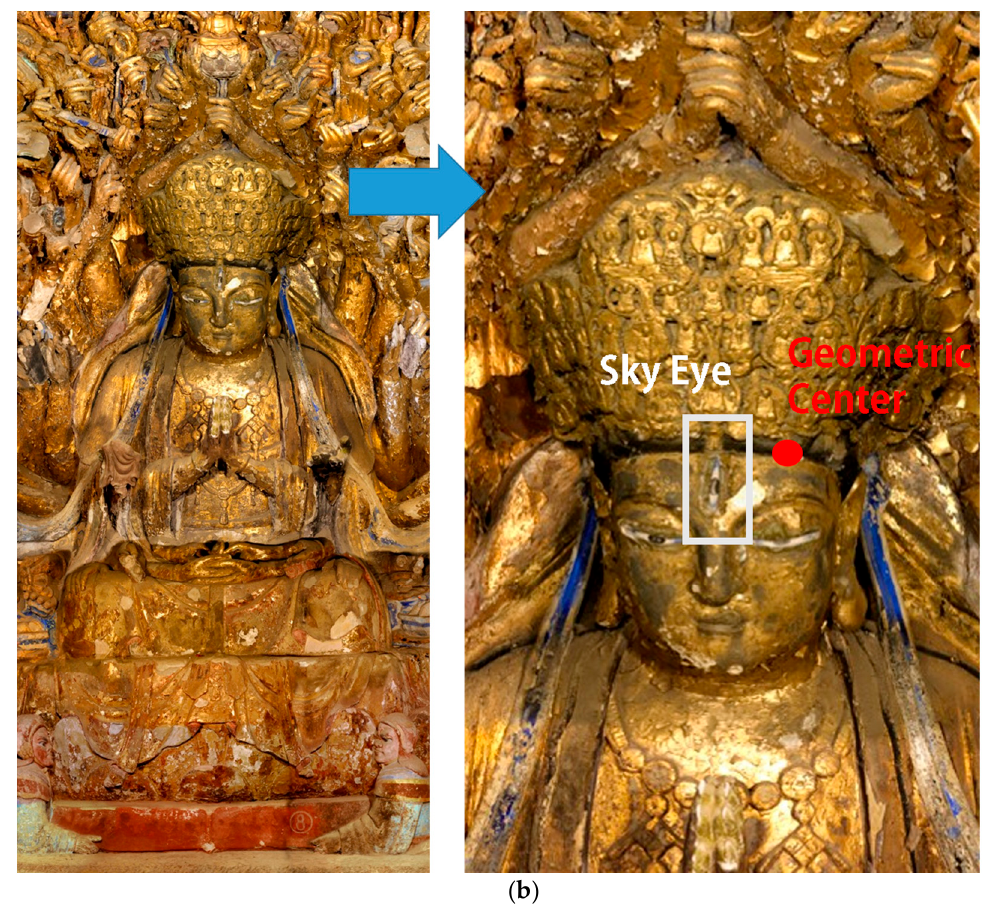
Figure 7. Global spatial geometric characteristics analysis of the Dazu Thousand-Hand Bodhisattva statue: ( a ) example of spatial geometric feature fitting on the object; ( b ) positions of geometric center point and “sky eye”.